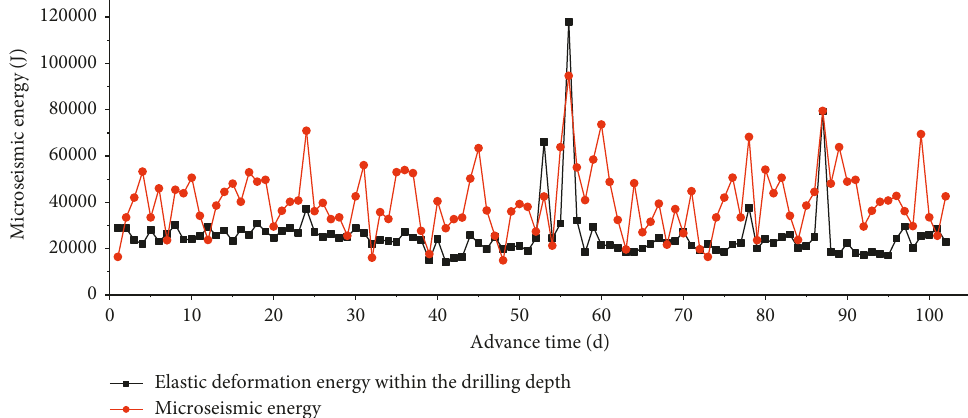
Figure 11: Relationship between the releasable elastic deformation energy and microseismic energy.